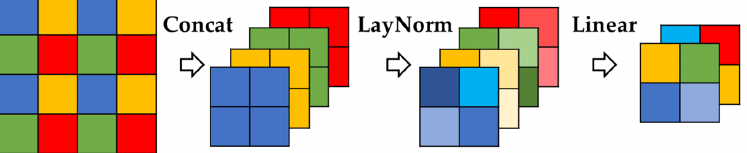
Figure 7. Example of patch-merging module’s downsampling details for a channel.